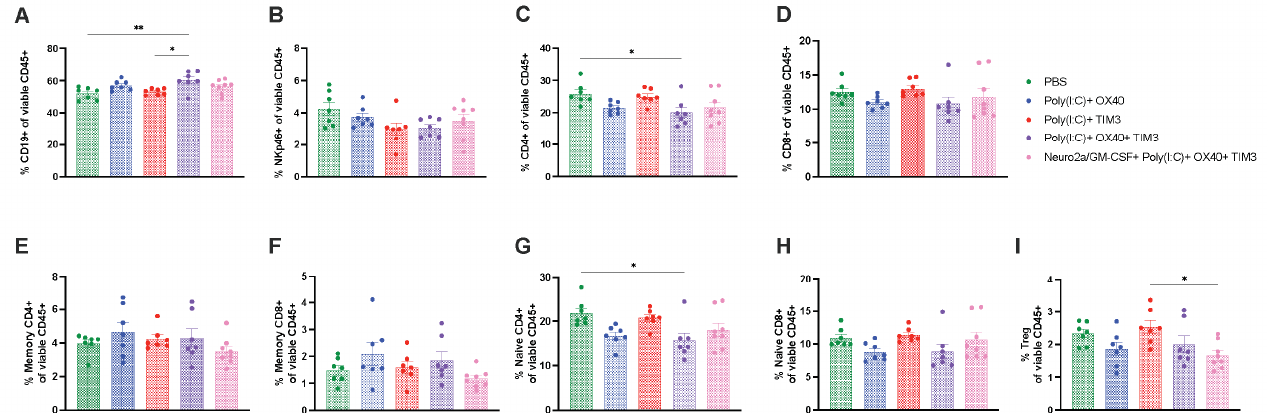
Figure 5. Combination immunotherapy modestly alters splenic immune cell subsets 24 h post treatment. Spleens were harvested 24 h after the second immunotherapy dose and prepared for flow cytometric analysis. Lymphoid cell subsets are illustrated as a percentage of total viable CD45+ cells and gated as follows: ( A ) B cells: CD19+ ( B ) NK cells: NKp46+ ( C ) Total CD4 T cells: CD4+ ( D ) Total CD8 T cells: CD8+ ( E ) Memory CD4 T cells: CD4+CD44+ ( F ) Memory CD8 T cells: CD8+CD44+ ( G ) Naïve CD4 T cells: CD4+CD62L+ ( H ) Naïve CD8 T cells: CD8+CD62L+ ( I ) T regulatory cells: CD4+CD25+FoxP3+. ( A – I ) Statistical differences were determined with a one-way ANOVA followed by Tukey’s post-hoc comparisons with the level of significance denoted by the number of asterisks: * p < 0.05, ** p < 0.01.